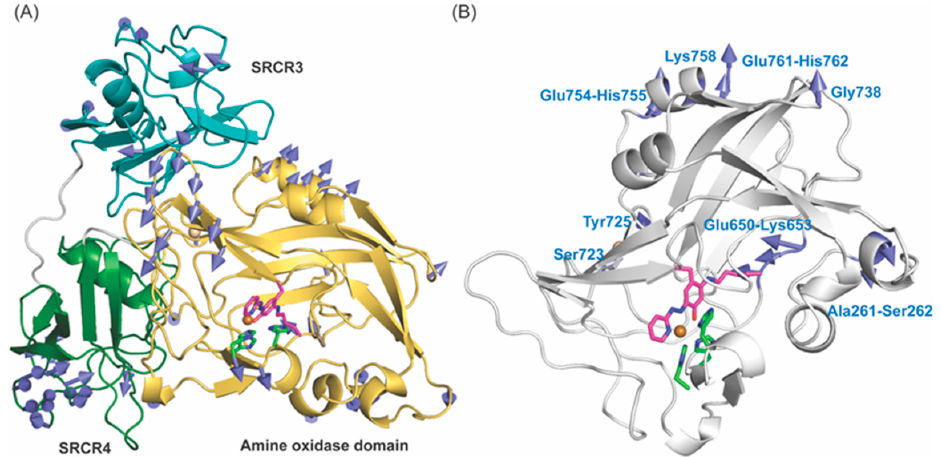
Figure 9. Displacement of the C α atoms in 2HP − inhibited Δ 1 − 2SRCR − LOXL2 ( A ) and the amine oxidase domain of 2HP − inhibited LOXL2 ( B ) where regions of peptides/amino acids exceeding 3Å ( A ) or 2.5Å ( B ) are visualized by vectors (in teal). In ( A ), SRCR3 and SRCR4 domains are in cyan and in green, respectively, and the amine oxidase domain is in yellow. The structures shown are in the very first phase and vectors indicating the difference between the first and the last phase of MD − simulation.